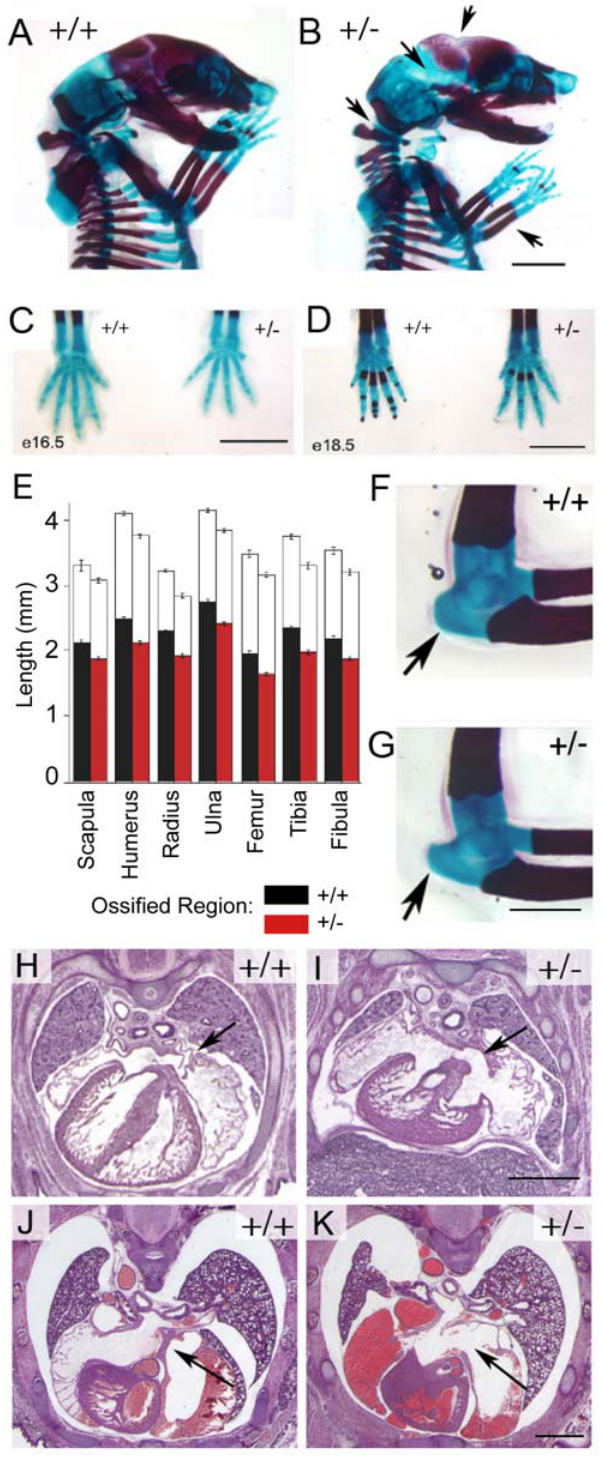
Figure 1. Abnormalities of bone and heart development in Nipbl + / 2 mice. (A,B) Cranial and trunk skeleton at E17.5, stained with alcian blue/alizarin red (blue staining shows cartilage; red shows bone). (A) Wildtype and (B) Nipbl + / 2 . Arrows indicate locations at which ossification is delayed in the mutant. (C) Forepaws at E16.5. Skeletal elements are patterned normally in the mutant, but are smaller. (D) Forepaws at E18.5. Delayed ossification is readily seen in mutant metacarpals and phalanges. Scale bars in (A–D)=2 mm. (E) Long